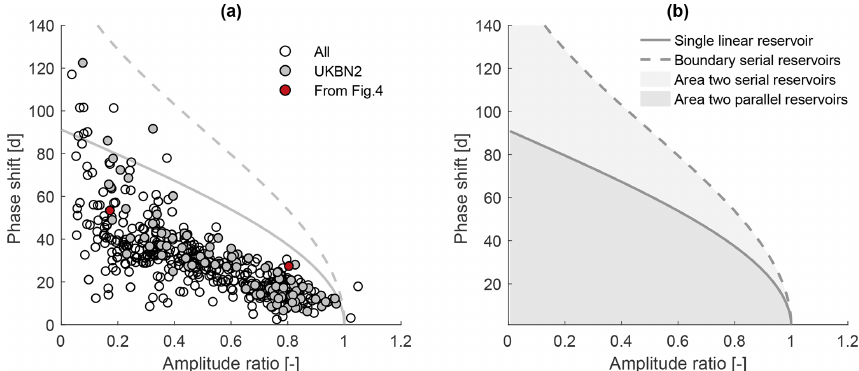
Figure 5. (a) Amplitude ratio against phase shift for UK catchments. Grey dots indicate benchmark catchments, and red dots indicate the two catchments shown in Fig. 4. The grey solid line indicates a single linear reservoir, and the grey dashed line indicates the outer envelope for two reservoirs in parallel. Note that both axes are limited (two catchments are not shown). (b) Theoretical areas and limits for a single linear reservoir, two reservoirs in series, and two reservoirs in parallel.